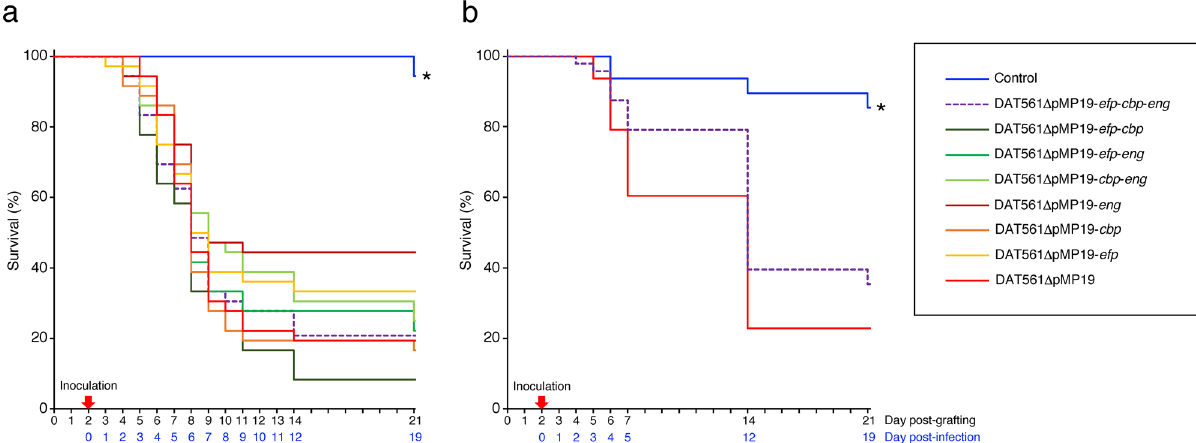
Figure 4. Evaluation of the virulence of M. plutonius DAT561ΔpMP19 and DAT561-derivative strains. The survival of A. mellifera larvae in Experimental Infections I ( a ) and II ( b ) is shown. M. plutonius strains and the number of larvae used in each group, and the infection doses are shown in Supplementary Table S4. All strains were cultured on KSBHI agar plates at 34.5 °C for 3–5 days under anaerobic conditions and used to prepare inocula containing 1.1–2.3 × 10 6 CFU/ml of M. plutonius . The experiments were carried out as described